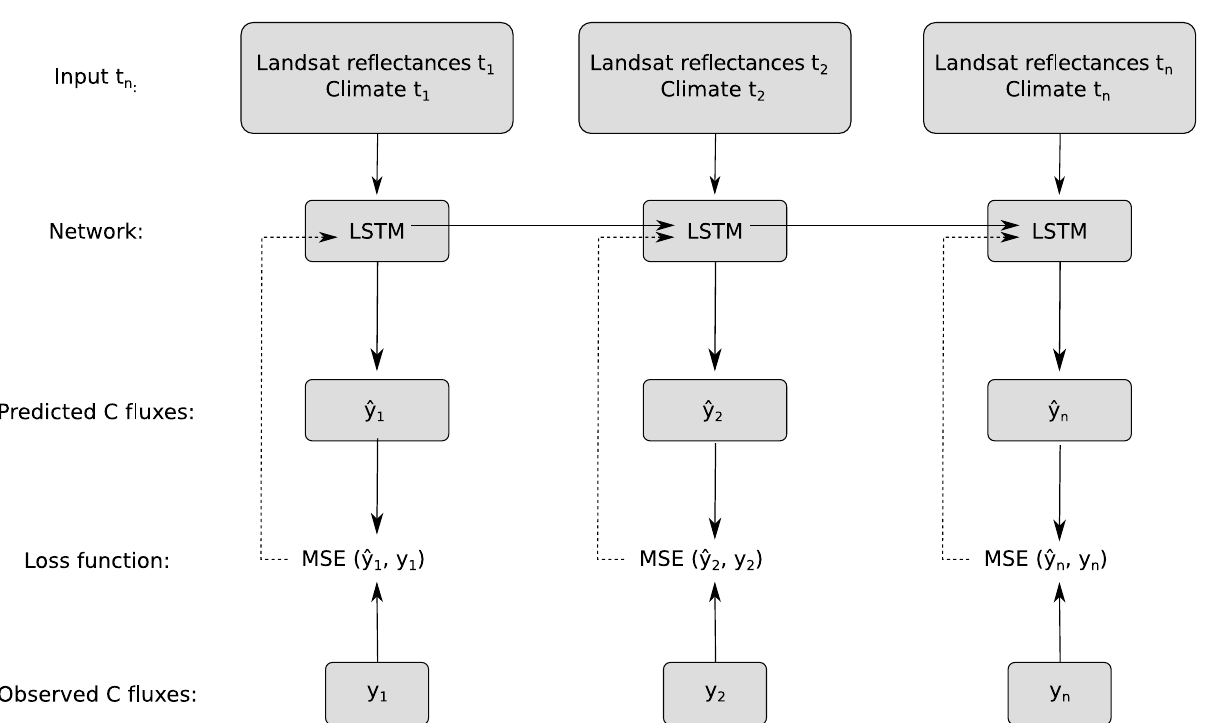
Fig 2. Flowchart of the proposed LSTM approach. Figure adapted from [61]. Each individual timestep is a monthly observation for the period 1982 to 2015. Landsat surface reflectances correspond to the seven spectral bands of the Landsat product; i.e. blue, green, red, near infrared, shortwave infrared 1, shortwave infrared 2, and thermal infrared. Climate corresponds to air temperature, precipitation, global radiation, and vapor pressure deficit. At each time step, an LSTM layer containing a set of cells or hidden neurons (10, 20, or 30) processes information based on the input of the current and of all previous observations. Predictions of net ecosystem exchange were performed at each monthly timestep by using information from both current and previous observations. The loss function was only calculated when net ecosystem exchange observations were available; i.e. measurement periods of LaThuile and FLUXNET2015 datasets.